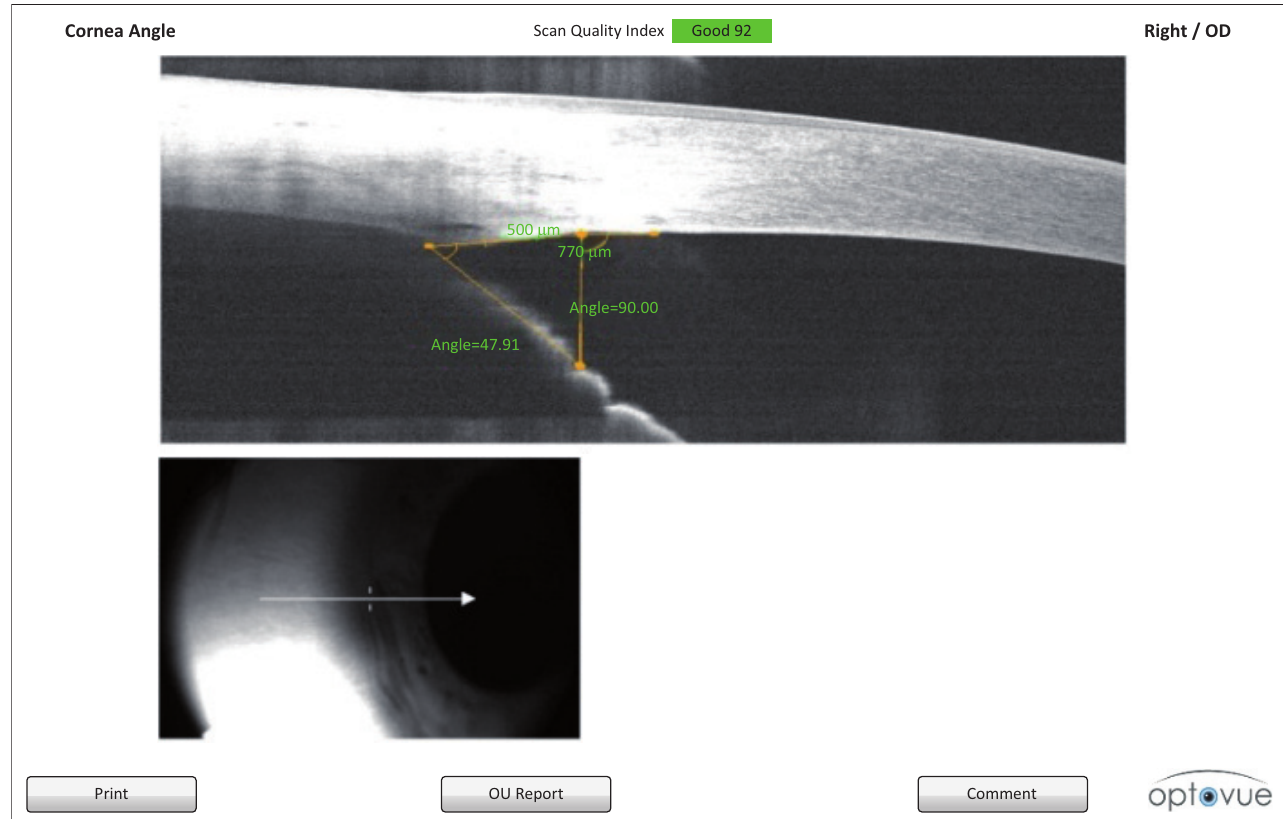
FIGURE 2: Cornea angle analysis showing the ACA variables (AOD500 and